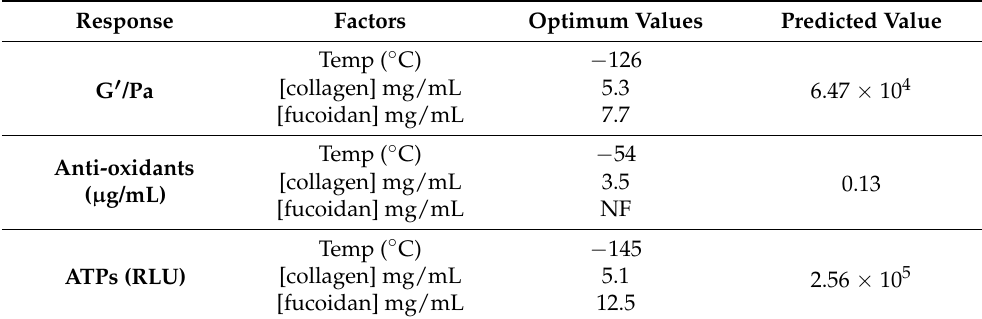
Table 4. Optimum conditions determined by surface factorial design and the predicted value according to the optimum